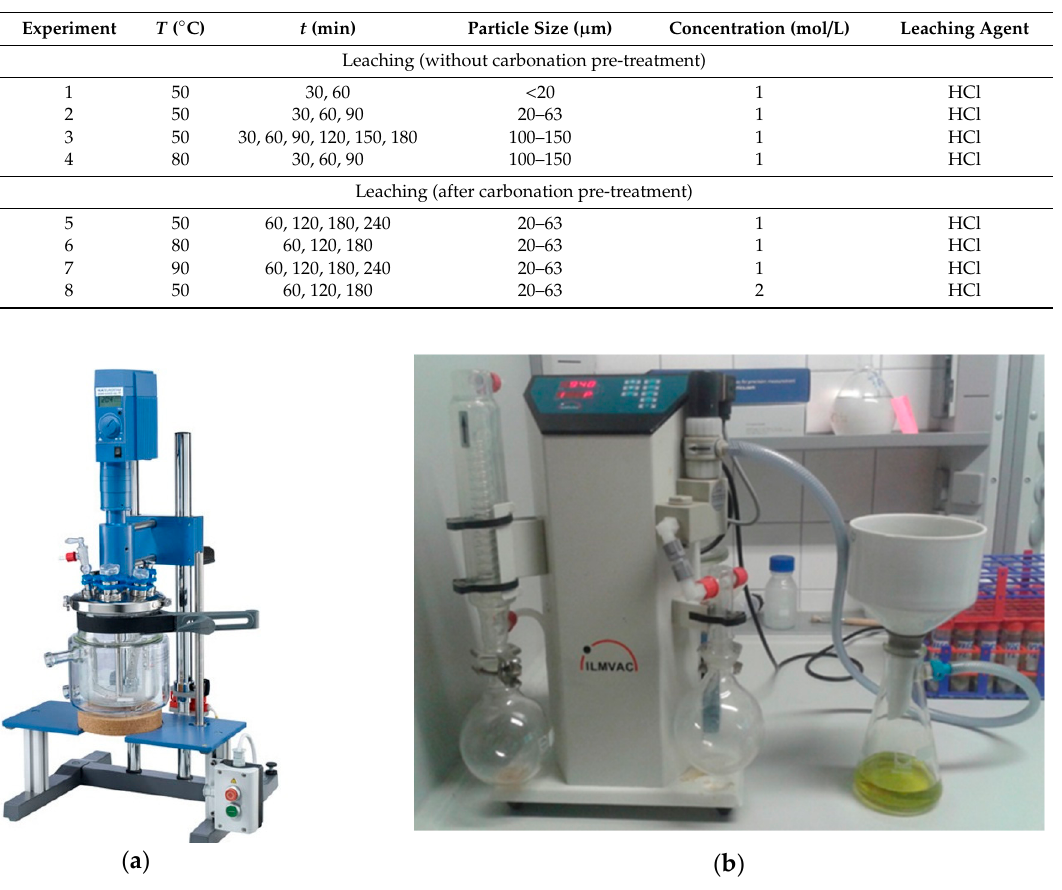
Table 3. Leaching parameters for the executed experiments with and without carbonation pre- treatment. Experiment